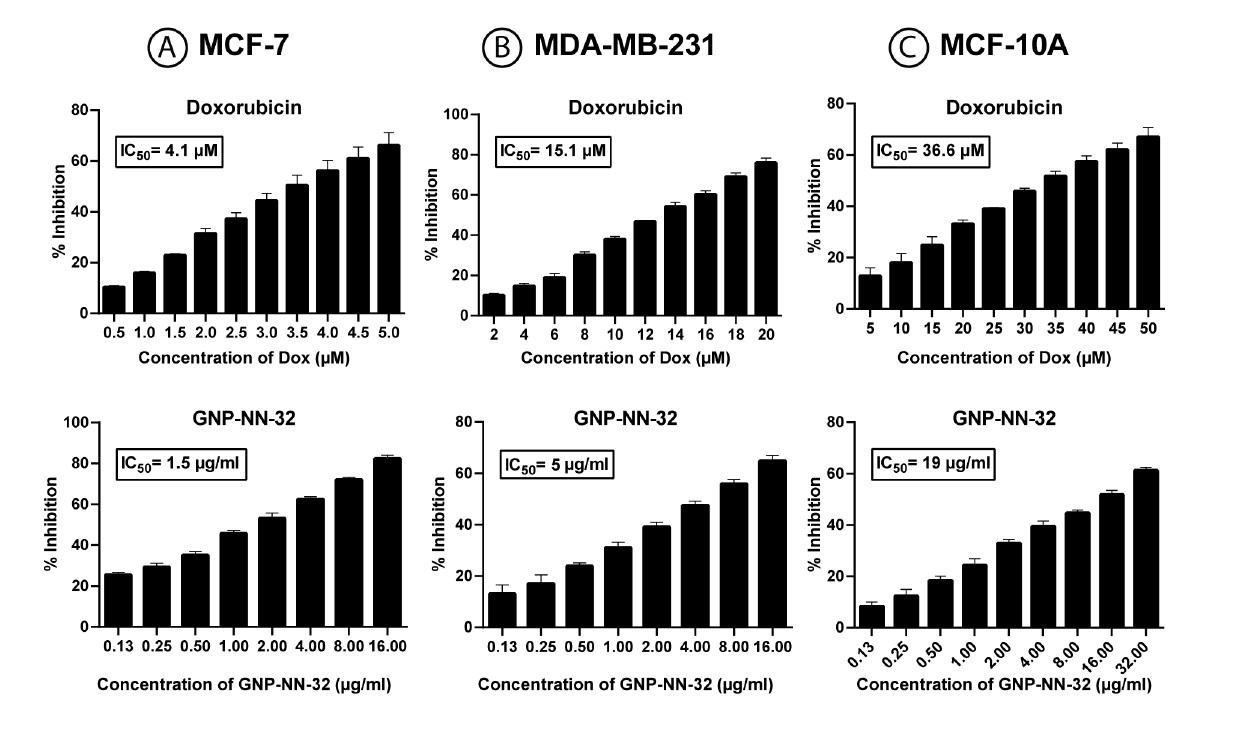
Figure 6. Inhibition of cells after 48 hours treatment of doxorubicin and GNP-NN-32. (A) MCF-7 cells, (B) MDA-MB-231 cells and (C) MCF-10A cells. Values are expressed as mean ± standard deviation (n = 3).